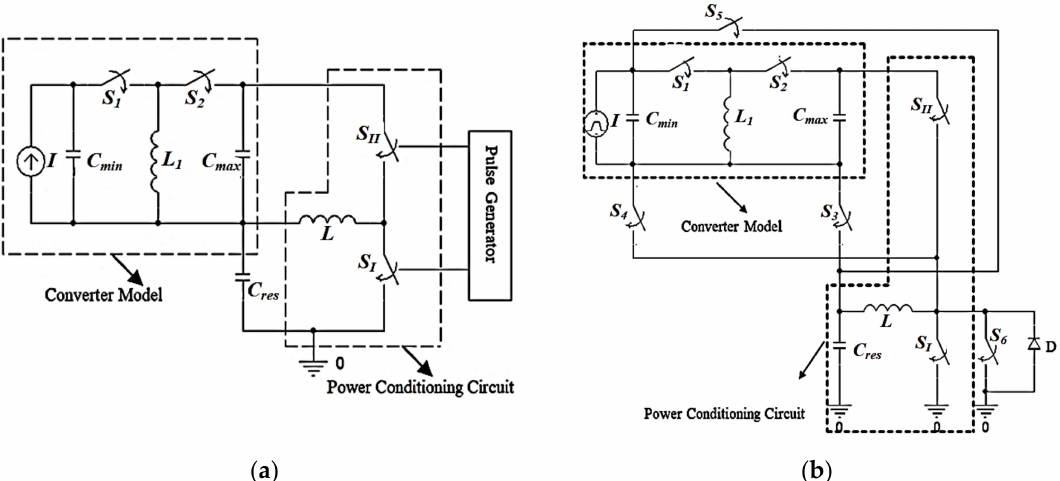
Figure 9. Demonstration of the converter behavioral circuit model with its power conditioning circuit ( a ) Converter behavioral circuit model with its power conditioning circuit, and ( b ) Final circuit with all the necessary added elements.